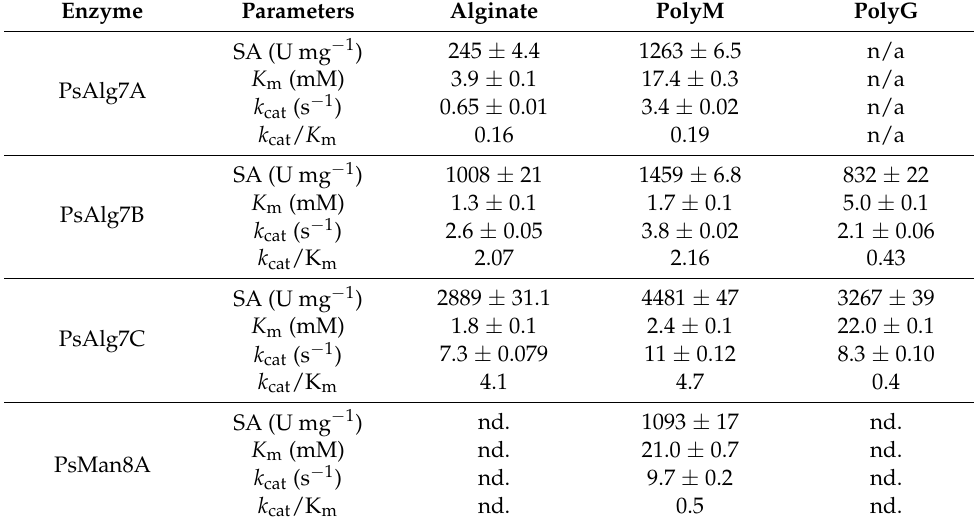
Table 1. Kinetic parameters and specific activities (SA) for the four alginate lyases on commercial substrates. The parameters were calculated by fitting the Michaelis–Menten model in the program Origin. ± represents standard errors on